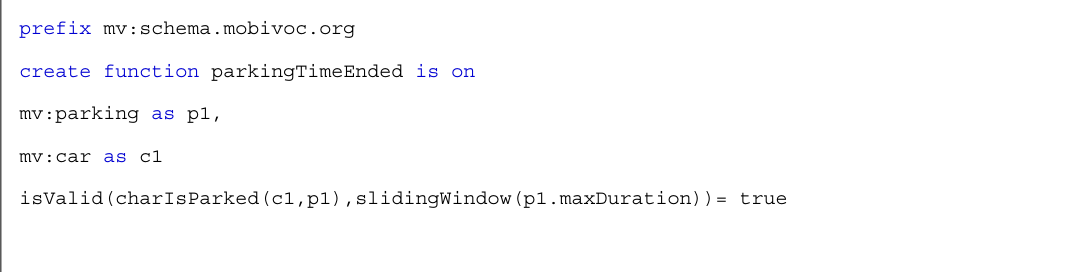
Scheme 13. Example of isValid function.